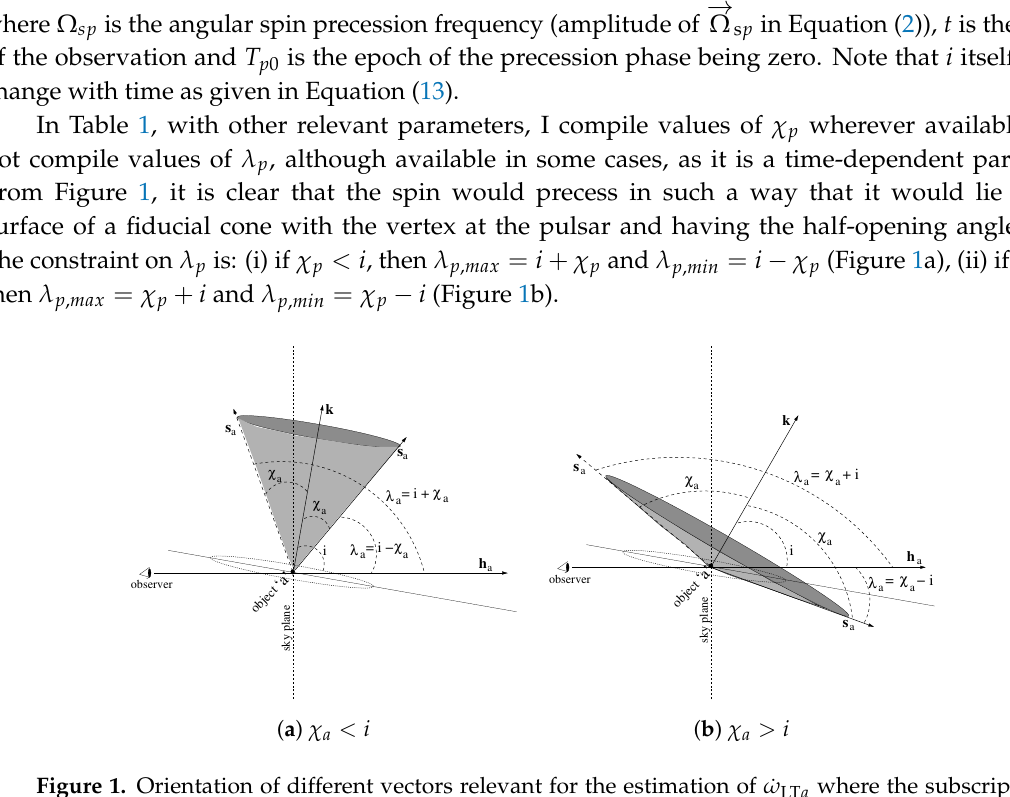
Figure 1. Orientation of different vectors relevant for the estimation of ˙ ω LT a where the subscript a refers to the object being observed, i.e., the pulsar (so the companion would be represented by the subscript a + 1). The vectors are as follow: k is the unit vector along the orbital angular momentum, h a is the unit vector along the line-of-sight and s a is the unit spin vector. The angles in the figures are: i is the inclination angle between the orbit of the pulsar and the sky-plane, as well as the angle between k and h a , χ a is the angle between k and s a and λ a is the angle between h a and s a . The left and right panels are for χ a < i and χ a > i , respectively. In both panels, two positions of s a are shown corresponding to maximum and minimum values of λ a (see the text). The pulsar, i.e., the object a , is located at the vertex of the fiducial cone (gray in color) made by the precessing s a around k